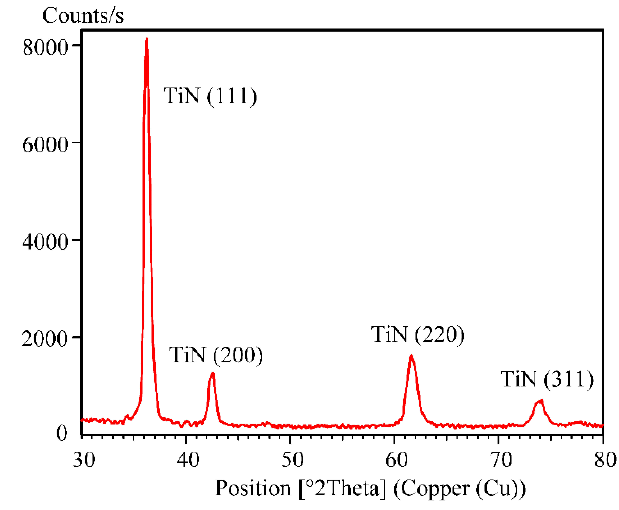
Figure 9 . X-ray diffraction pattern of the coating synthesized in the center of the plate.